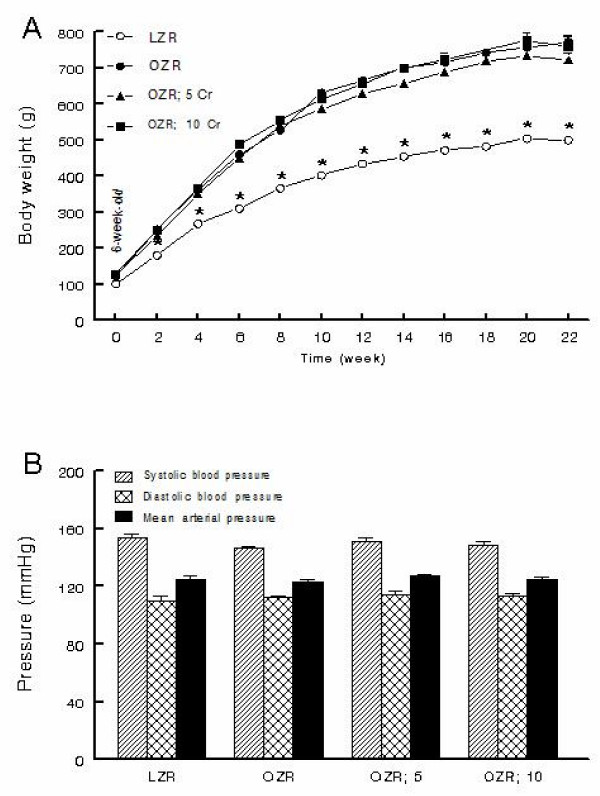
Body weight and blood pressure. Panel A shows time-course of changes in body weight while panel B shows blood pressure of lean Zucker rats (LZR), untreated obese Zucker rats (OZR) and OZR treated with diets containing 5 and 10 mg/kg of chromium as Cr(pic)3 (i.e., OZR; 5 Cr and OZR; 10 Cr, respectively). The treatments were initiated at 6 weeks of age (i.e., time 0). Data are means ± SEM of 9-10 animals/group. * p < 0.05 compared to the other groups at the same time point.